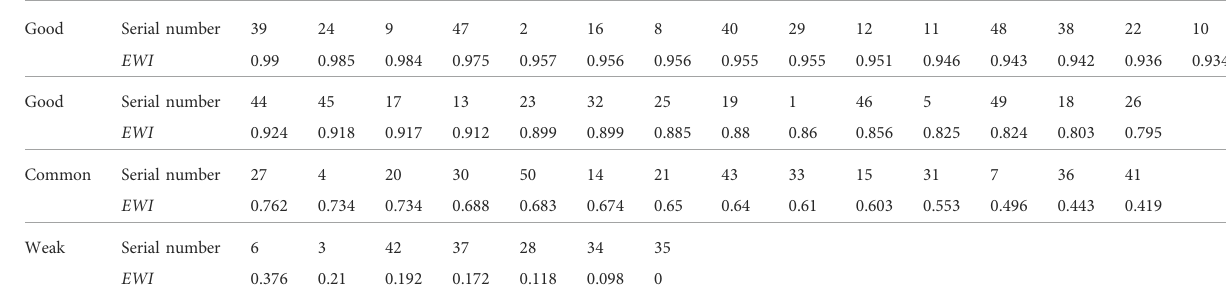
TABLE 2 EWI of species or species compositions of 50 example